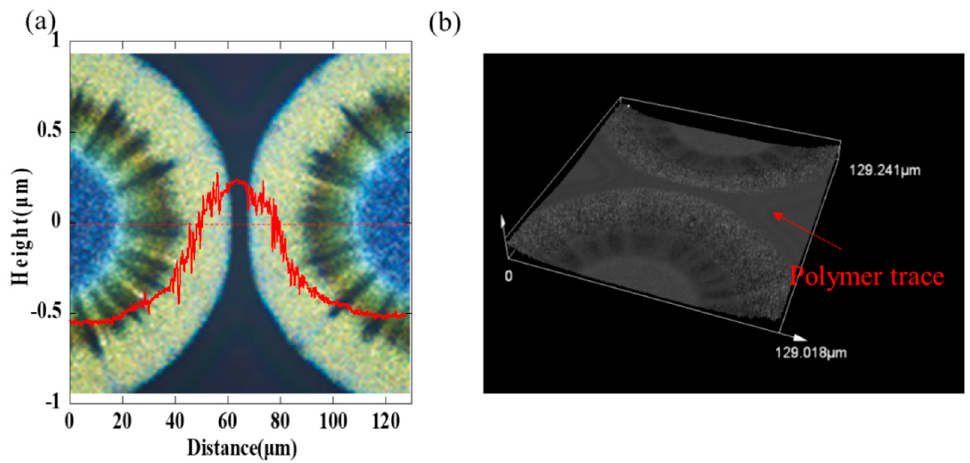
Figure 4. ( a ) The gap between adjacent droplets and the profile of the red line in the center; ( b ) obvious polymer trace around the ring structure. Images were obtained by the confocal laser scanning microscopy.